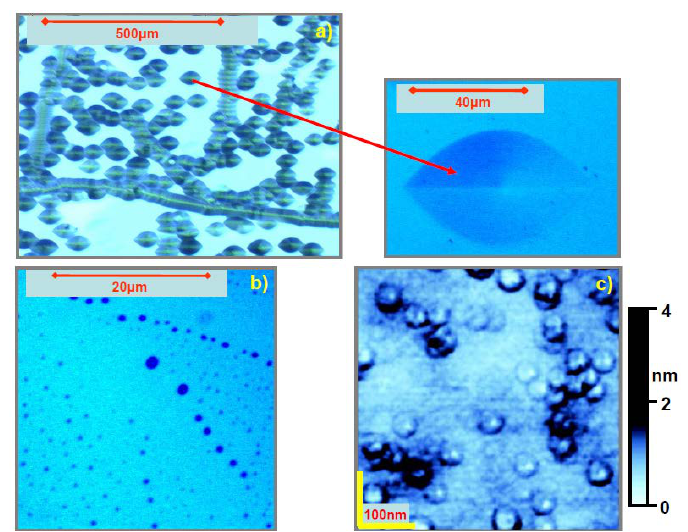
Figure 6. Two examples of etch pits characterized with optical inspection: ( a ) of the surface of a TiO 2 (110) etched in molten KOH (400 °C, 10 min), magnification shows a typical shape of individual etch pits; and ( b ) of a TiO 2 (100) surface etched using buffered HF. In the latter case, a much higher density of dislocations is visible due to the fact that the HF-buffered etching is less effective than using KOH etchant, which gives an indication of different dislocation densities with respect to etching depth; ( c ) atomic force microscopy (AFM)-topographic picture of etch pits (with similar shapes) on TiO 2 (110) surface (for the decoration of the exit of dislocation only a short etching using HF was applied, adapted from [68]). This gives to support to a tendency of agglomeration or so-called bundling of dislocations. The determined density of dislocation is here 1.5 × 10 10 per cm 2 .